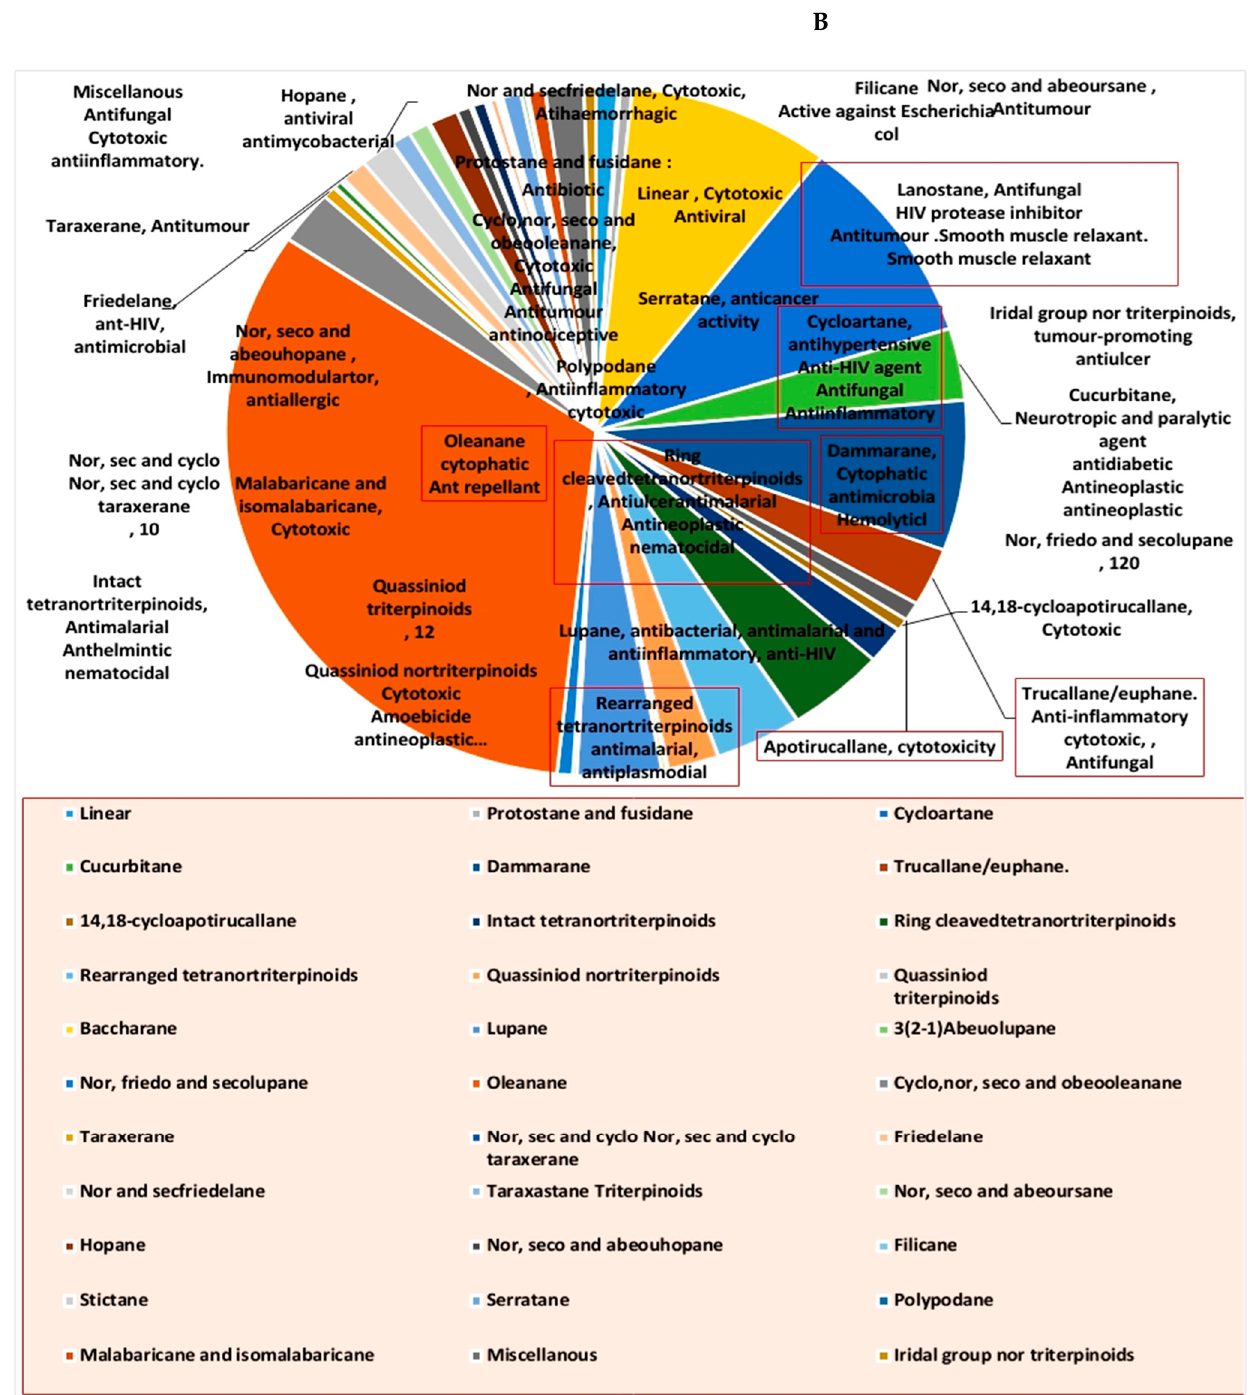
Figure 2. Pie charts indicating the biological activities of steroids ( A ) and triterpenes ( B ).